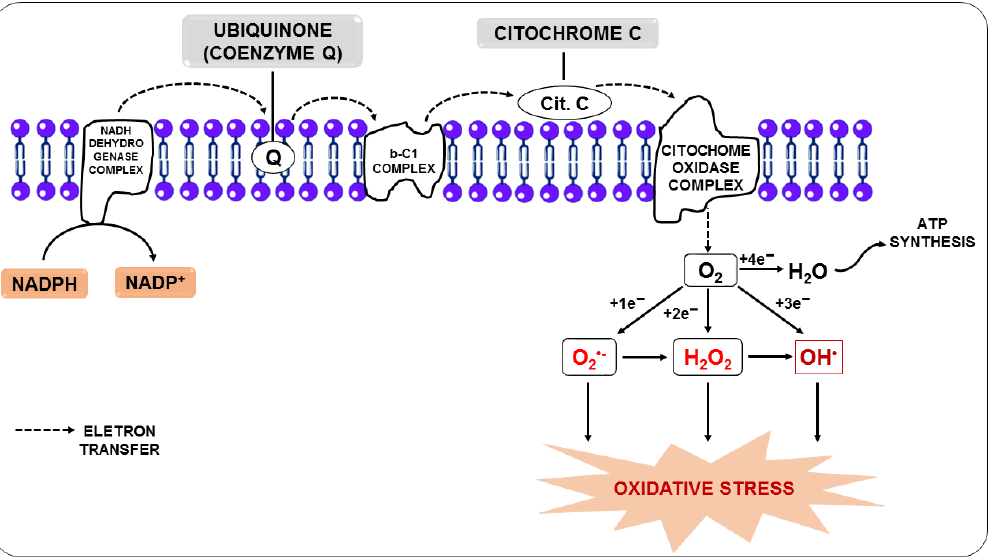
Figure 1. Production of reactive oxygen species from the transfer of electrons from the electron transport chain.